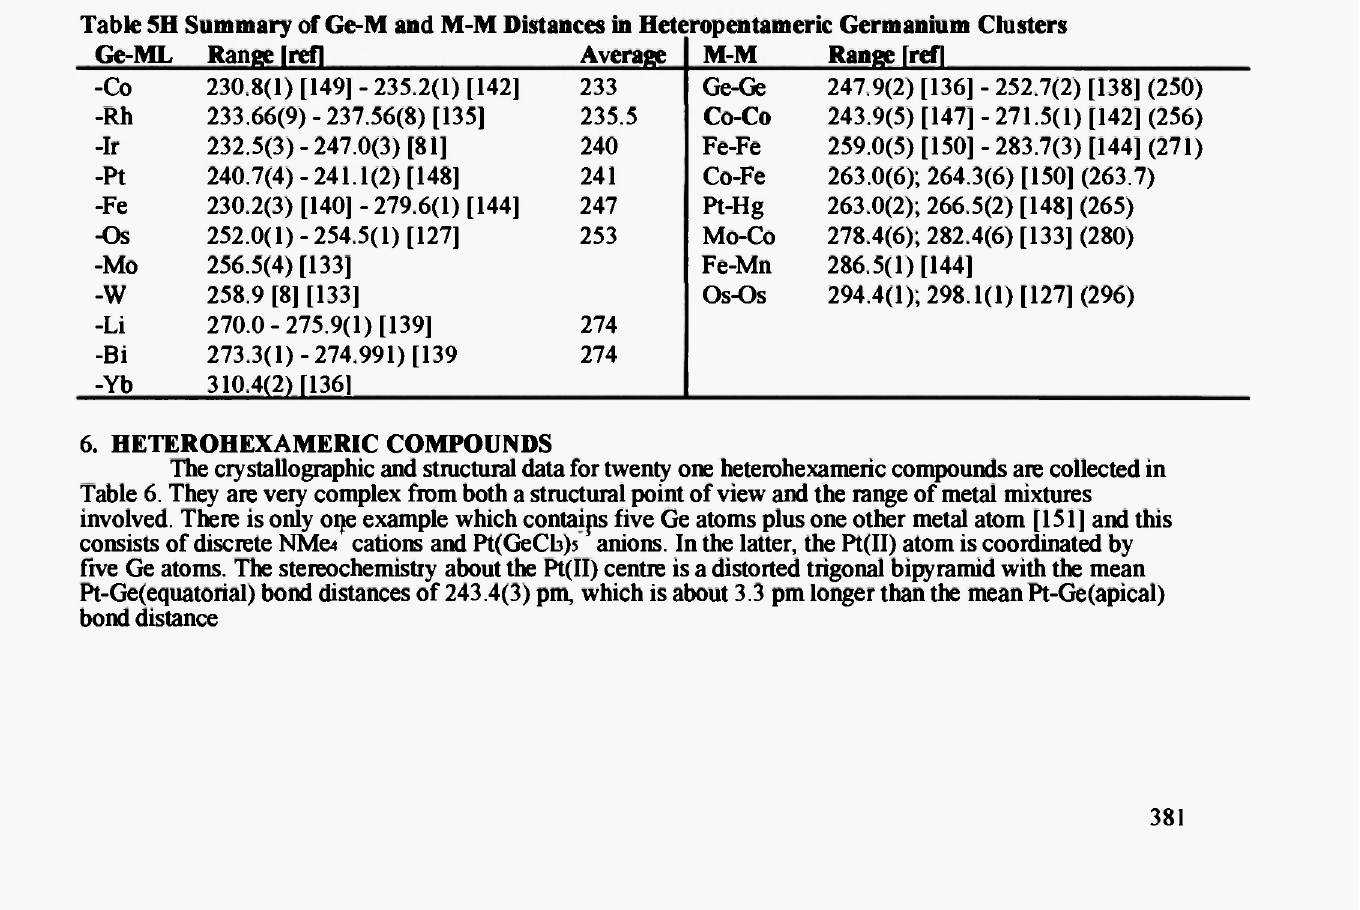
Table SH Summary of Ge-M and M-M Distances in Heteropentameric Germanium